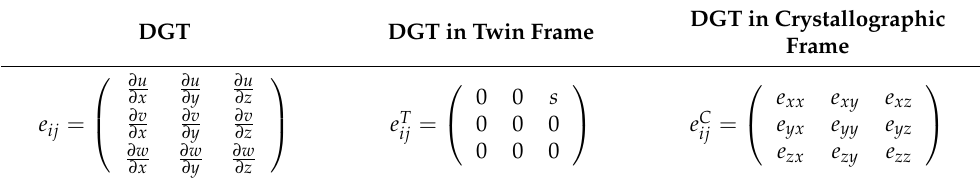
Table 3. Displacement gradient tensor